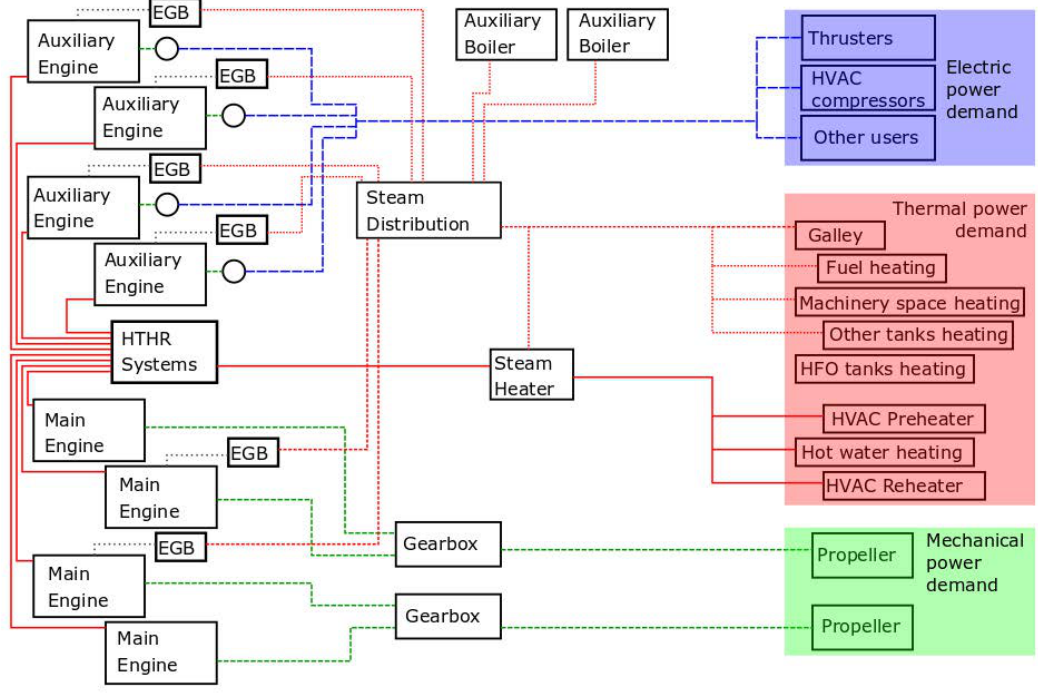
Figure 2. Layout of the energy system of the case study. Energy converters are listed on the left, while the energy demands are summarized on the right. The blue, red and green colors refer to electric power, heat, and mechanical power,